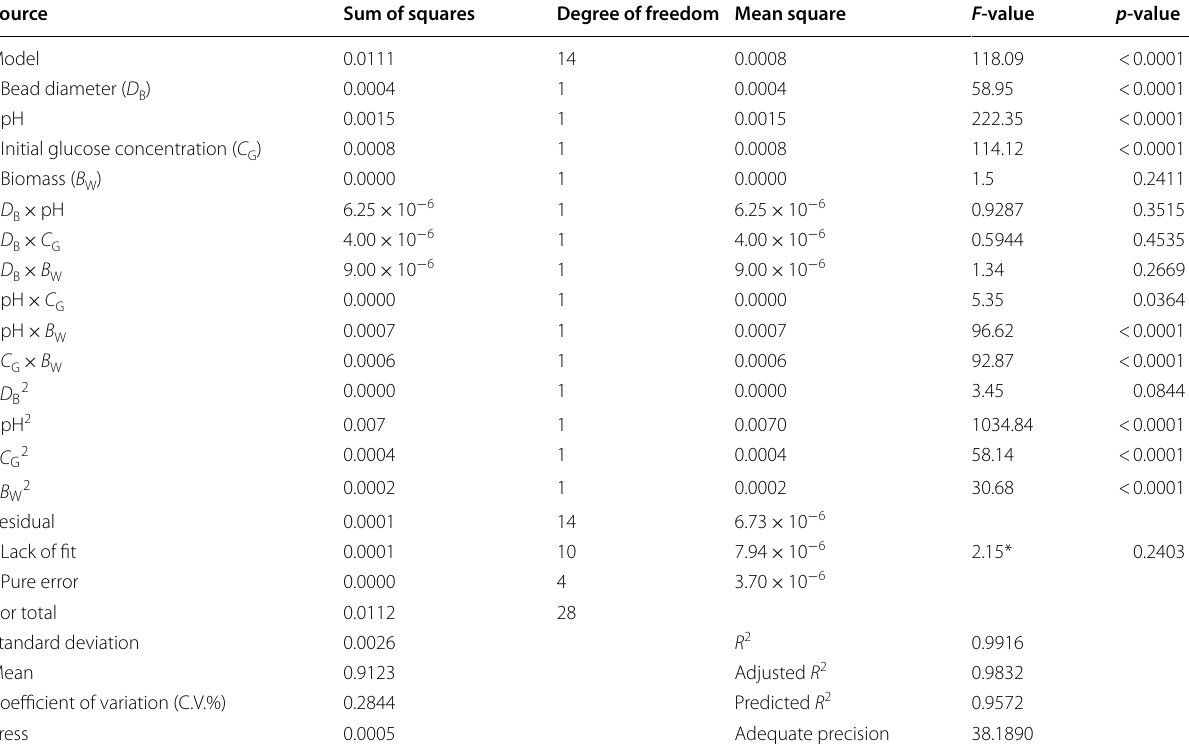
Table 4 ANOVA for LA yield by immobilized L. pentosus ATCC 8041